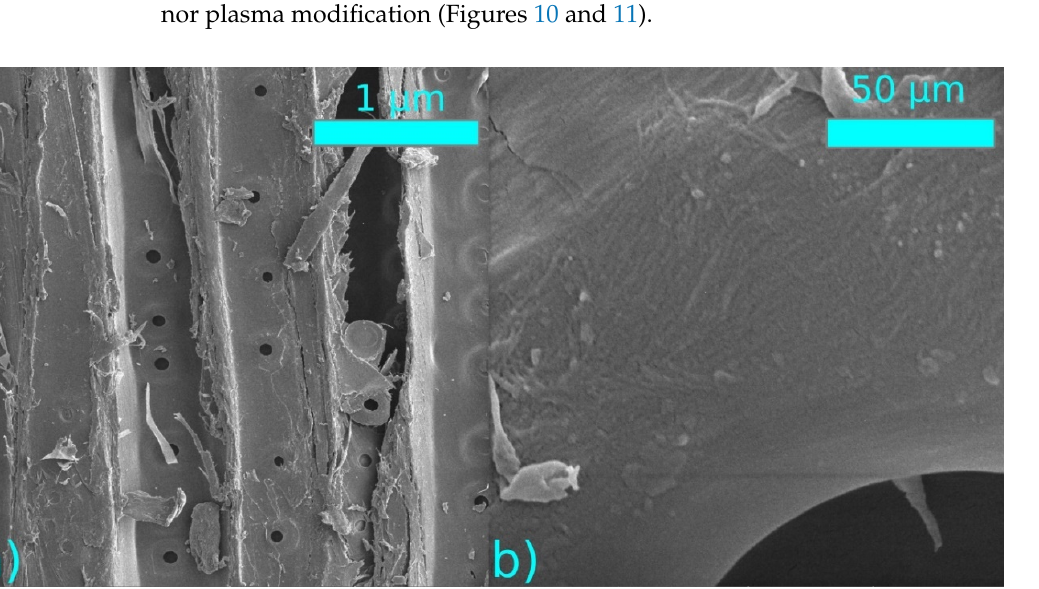
Table 2. The maximum measured temperature of the wood sample surface. Distance.